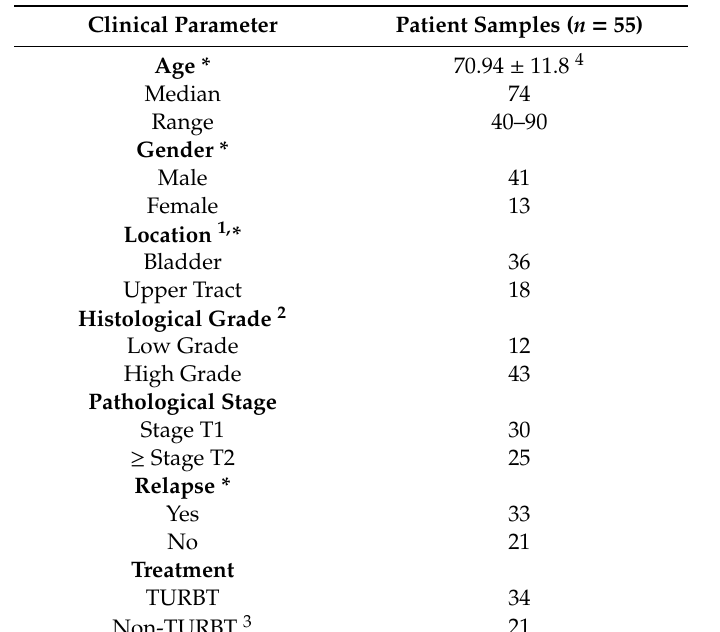
Table 2. Summary of clinical-pathological data of urothelial carcinoma